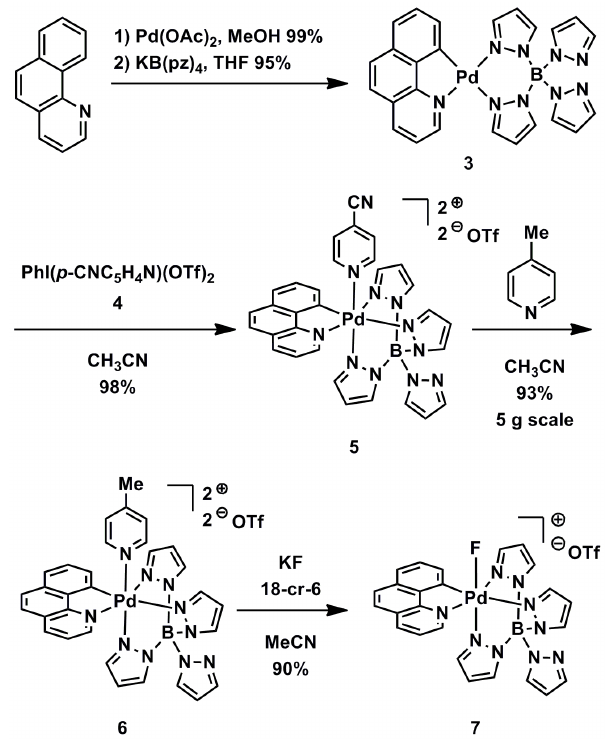
Figure 2. New electrophilic fluorination reagent. Synthesis of high-valent palladium complex 7 that is an electrophilic fluorination reagent derived from complex 6 through fluoride capture.